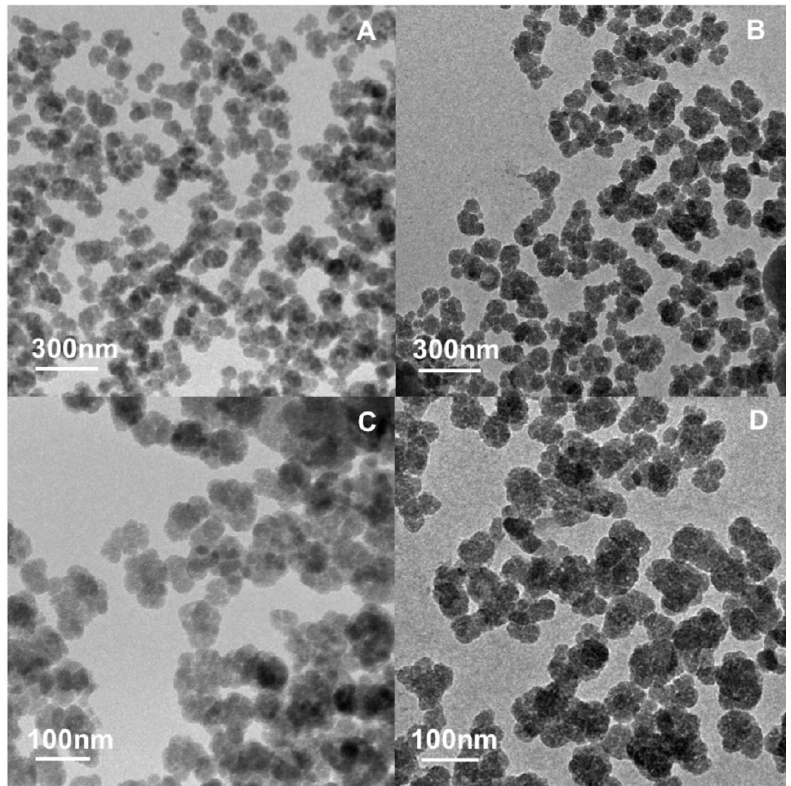
Figure 2. TEM micrographs at di ff erent magnifications of ( A , C ) SiO 2 / HA_p and ( B , D ) SiO 2 / HA_c.